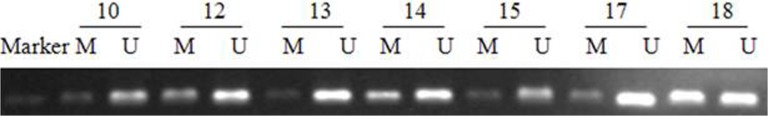
Representative Zic1 promoter methylation, as determined by methylation-specific polymerase chain reaction (MSP) assay.M: Methylation-specific primers; U: Unmethylated-specific primers.